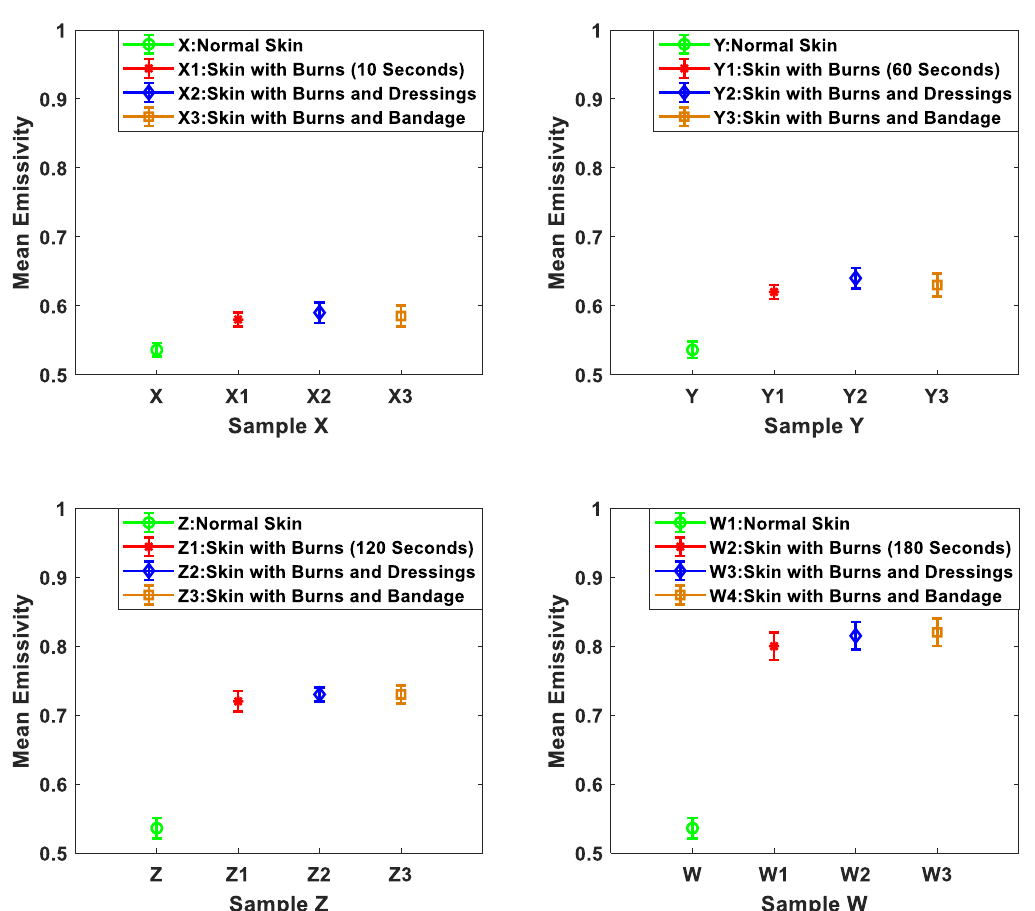
Figure 8. Mean emissivity values and standard deviation bars for porcine skin samples (obtained from the same animal) before and after the application of localized heat treatment. Samples X, Y, Z, and W represent normal skin. X1 represents skin with burns after 10 s of heat treatment, Y1 represent skin with burns after 60 s of heat treatment. Z1 represents skin with burns after 120 s of heat treatment, and W1 represents skin with burns after 180 s of heat treatment. X2, Y2, Z2, and W2 represent skin with burns and dressing materials (six gauze burn bandage). X3, Y3, Z3, and W3 represent skin with burns and single-layer light support bandage.